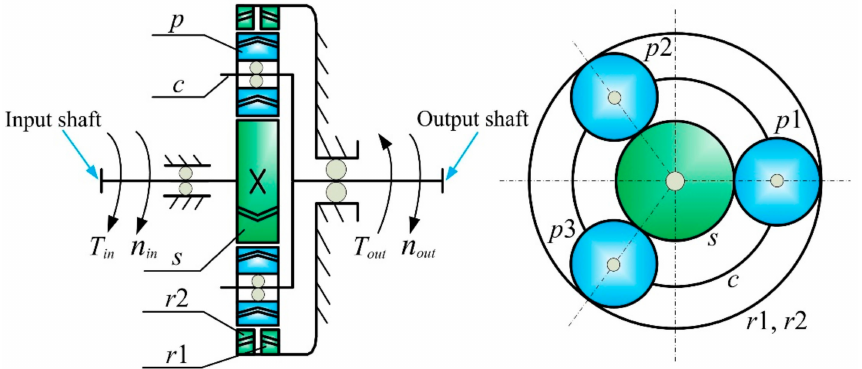
Figure 1. Structural diagram of herringbone planetary